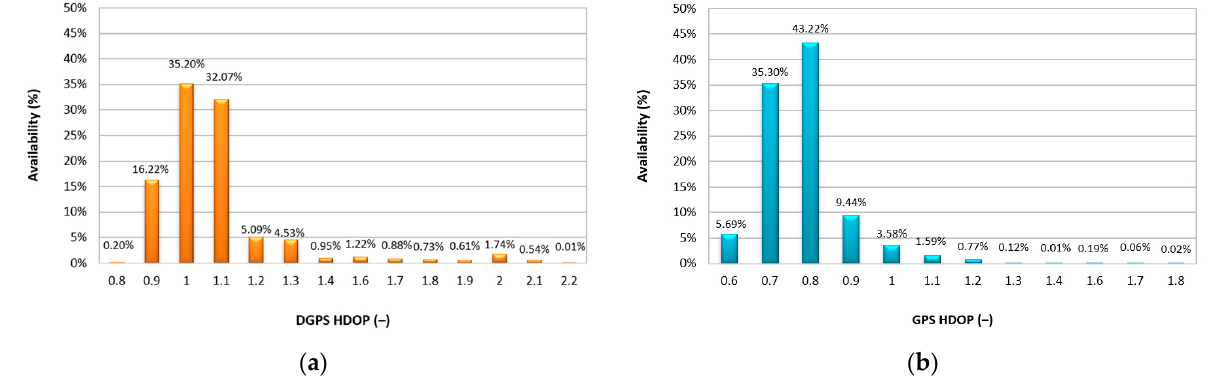
Figure 5. The percentage availability of individual HDOP values for the maritime DGPS system ( a ) and the percentage availability of individual HDOP values for the GPS system ( b ).